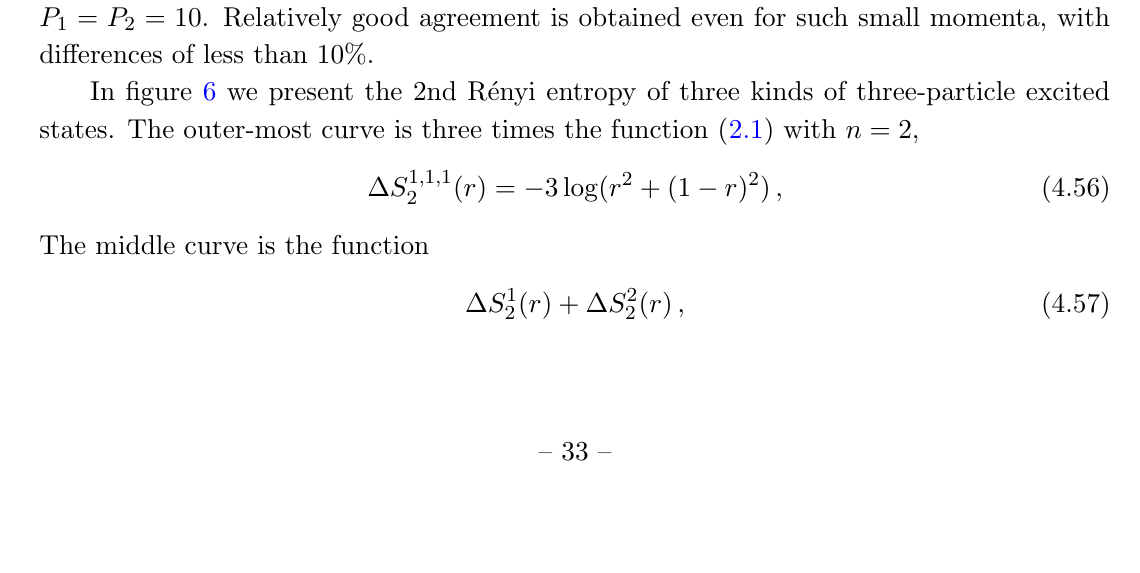
Table 2 . The di(cid:11)erence of 2nd R(cid:19)enyi entropies of two-particle excited states with equal momenta. The second row shows the exact values of the function (4.55). The third and fourth rows show numerical values for the given momenta. The other parameters are m = 1, L = 10 and (cid:1) x = 0 : 01. For P 1 = P 2 = 2 agreement is poorer, especially for small ‘ due to the momenta being too small. More precisely min(2 (cid:25)=P 1 ; (cid:24) ) = 1 which is larger than some of the values of ‘ considered, a regime where we do not expect our formulae to hold. However the disagreement with (4.55), even for such small momenta is relatively small. For P 1 = P 2 = 10 (as for 50, in (cid:12)gure 5) agreement is excellent for all values of r